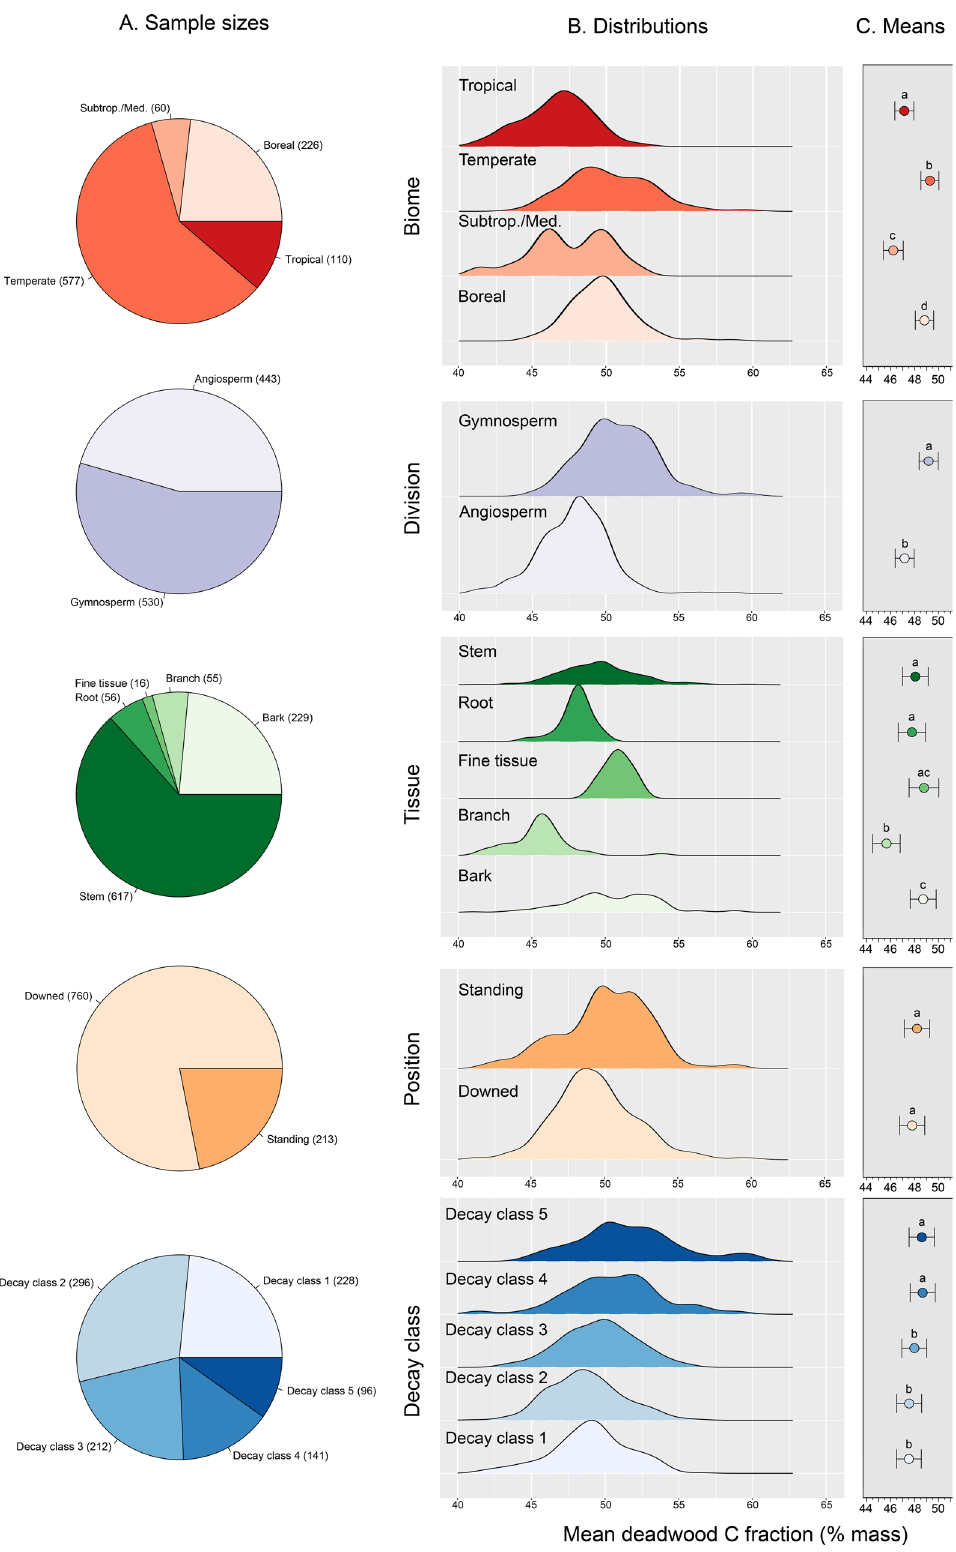
Fig. 2 Sample sizes, distributions, and mean dead wood carbon fraction (CF) estimates across biomes, taxonomic divisions, tissue type, dead wood position, and decay class. Panel A presents sample sizes. Panel B presents kernel density estimates fi t to subsets of the dataset (based on the sample sizes presented in A ). Panel C represents least-squares mean estimates (±s.e.) from a linear mixed-effects model fi t to the entire dead wood dataset ( n = 973). Within a given data subset, different letters above mean estimates denote statistically signi fi cant differences (at p < 0.05) in mean dead wood C